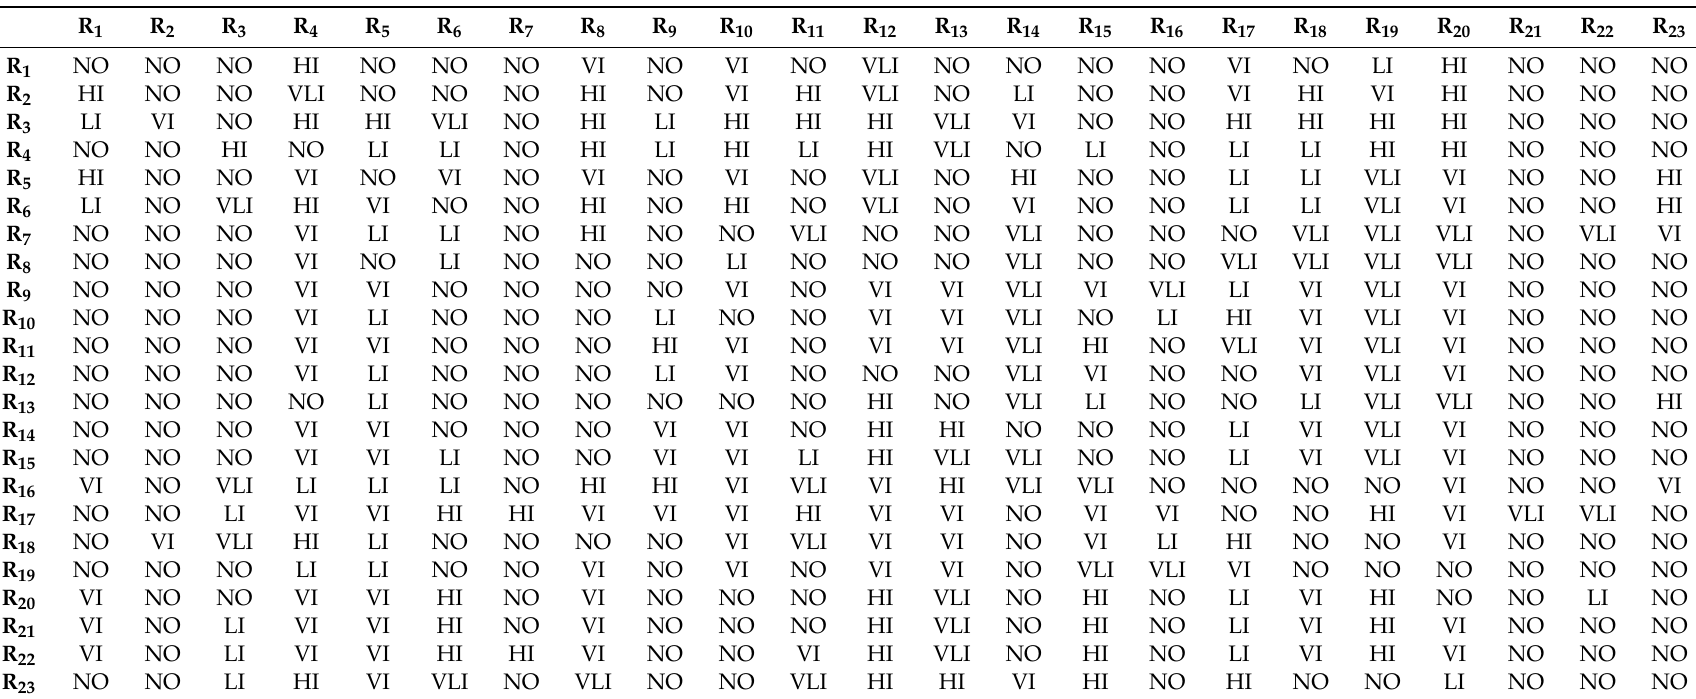
Table 8. Input matrix filled in by the expert on safety and security for the automotive